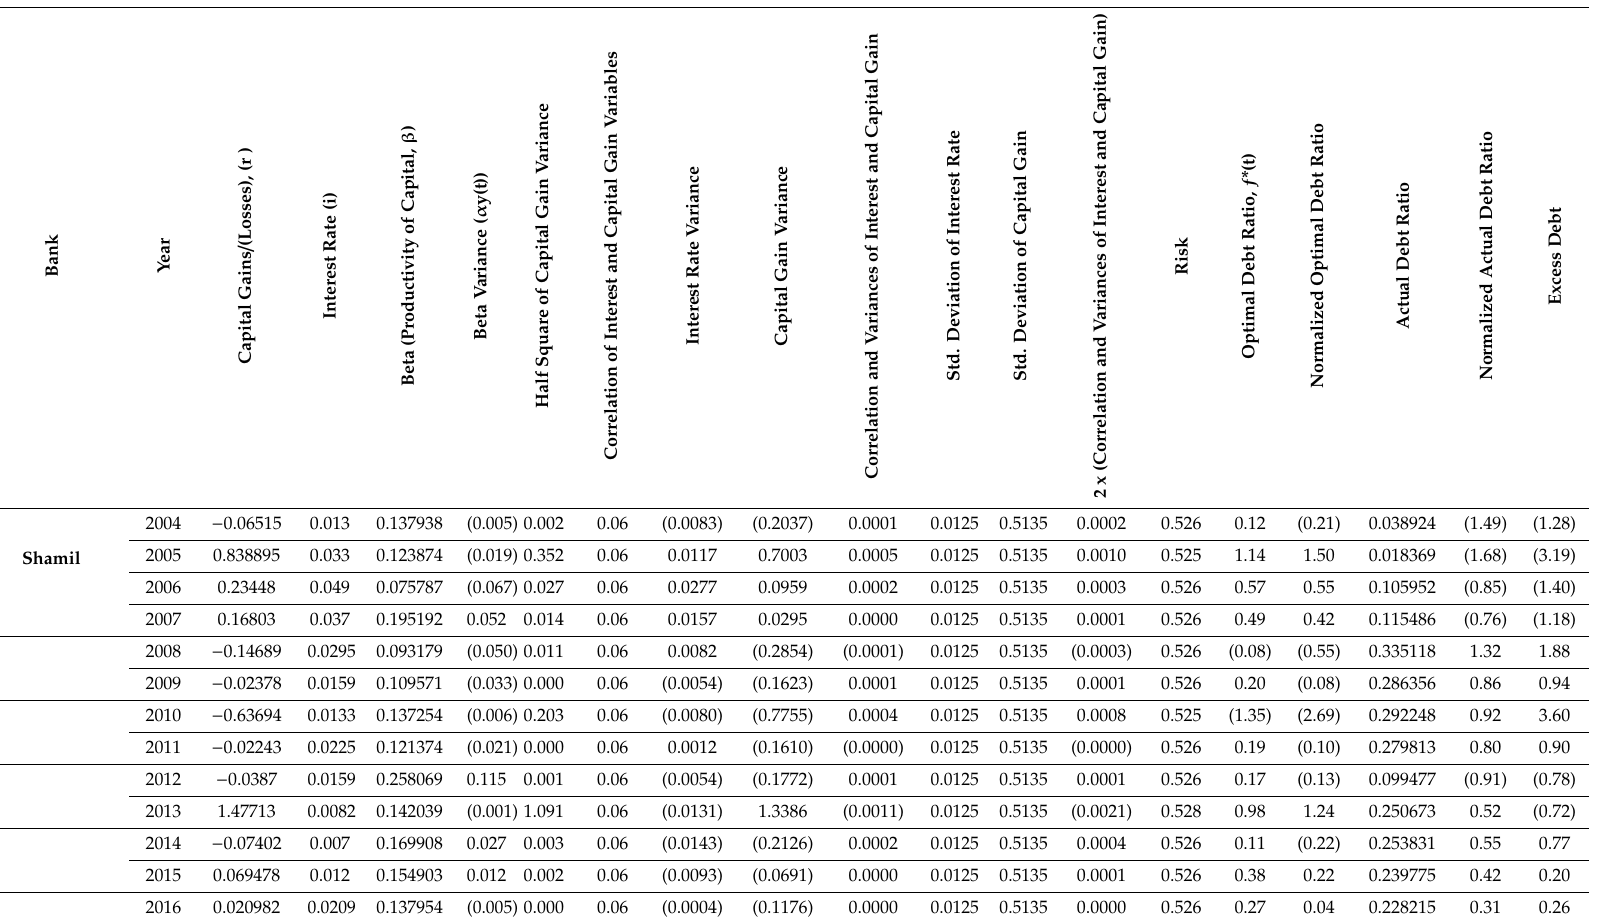
Table A5. Calculations of Optimal and Excess Debt: